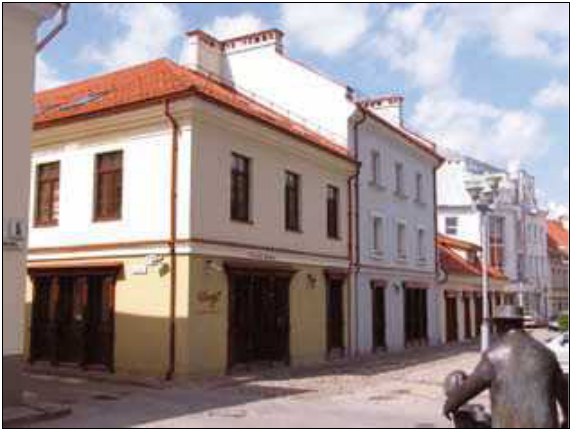
fragmentas (archit . h. Štau­dė, J. Leskevičiu­s) Fig. 2. Fragment of tymo residential qu­arter in Maironis st.